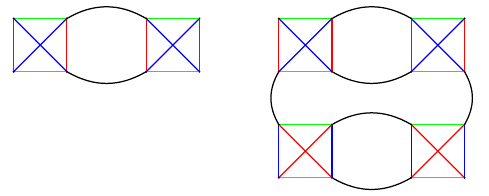
Figure 2 . Two 4-colored graphs, with external tensor contractions equivalent to the pillow (left) and double-trace (right) invariants.